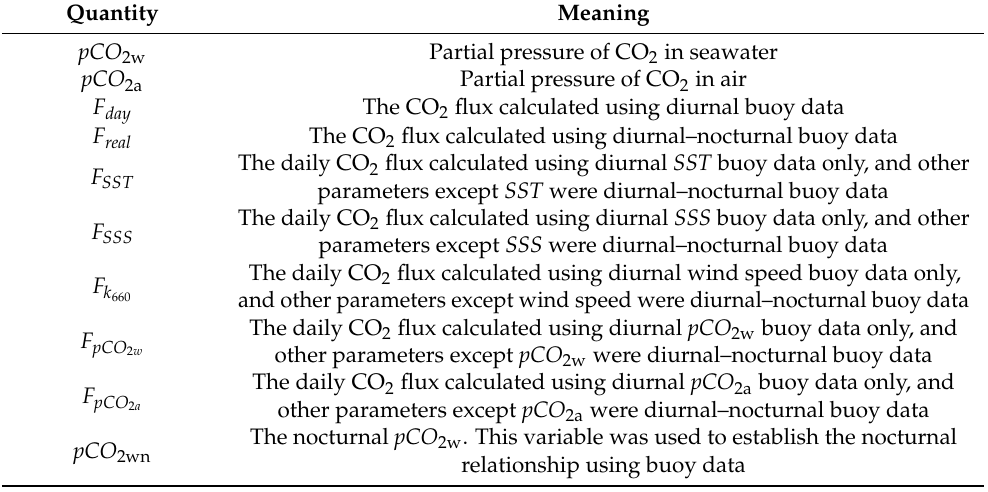
Table A1. Variable symbols in this article defined in the corresponding